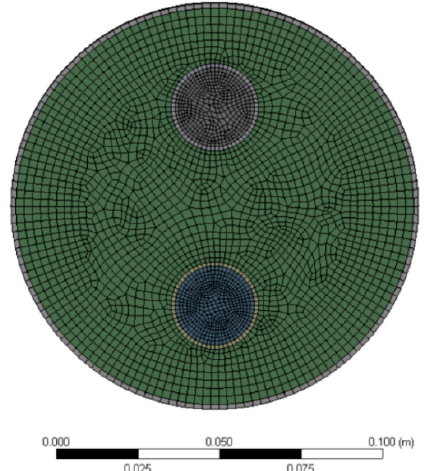
Figure 2. The mesh grid on the pipe cross-section.